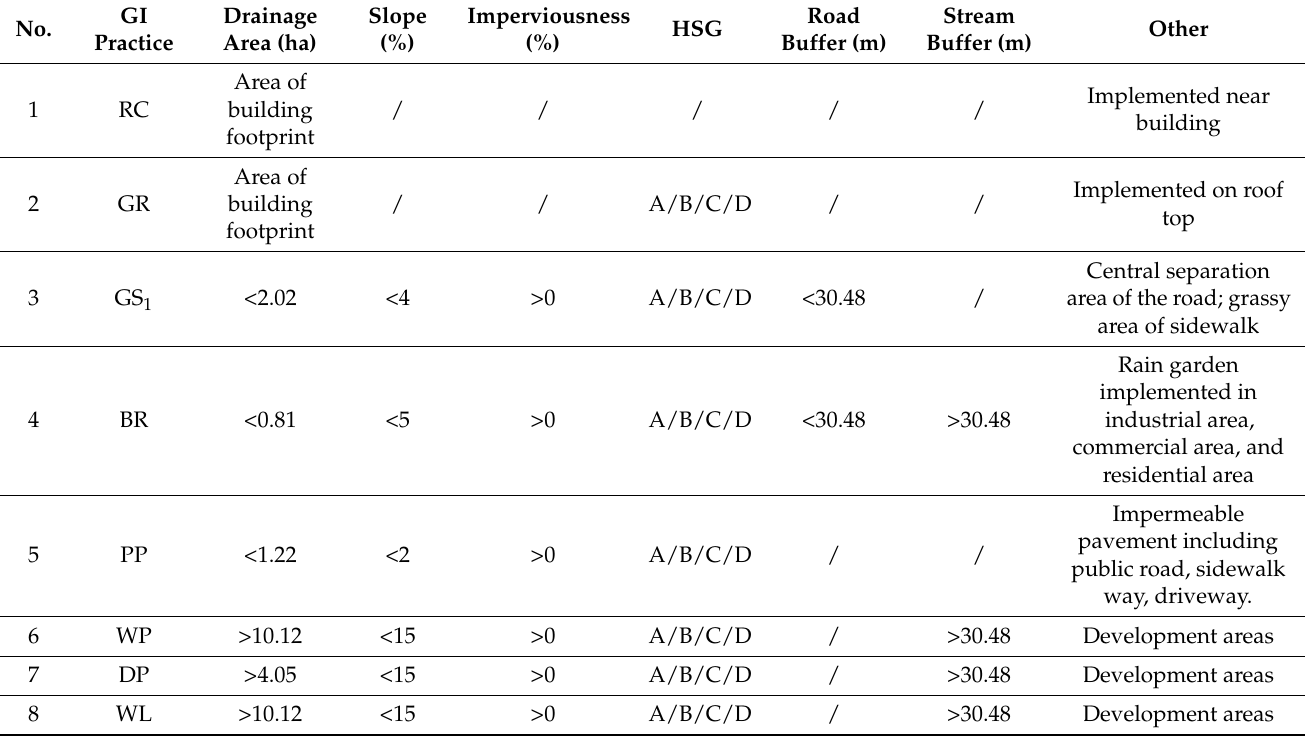
Table 2. Criteria for GI practice locations